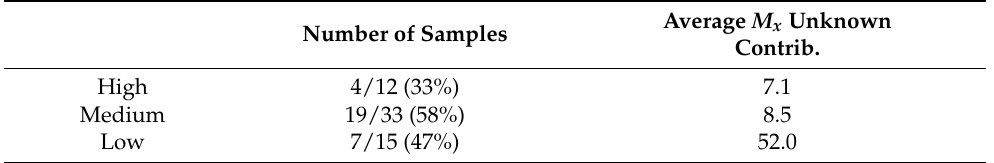
Table 1. Detection of unknown alleles in the shedder samples and the proportion of unknown DNA detected for the three different shedder classes. DNA from unknown contributors was detected in 30/90 samples, the average M x proportion from unknown contributors was highest for low shedders,